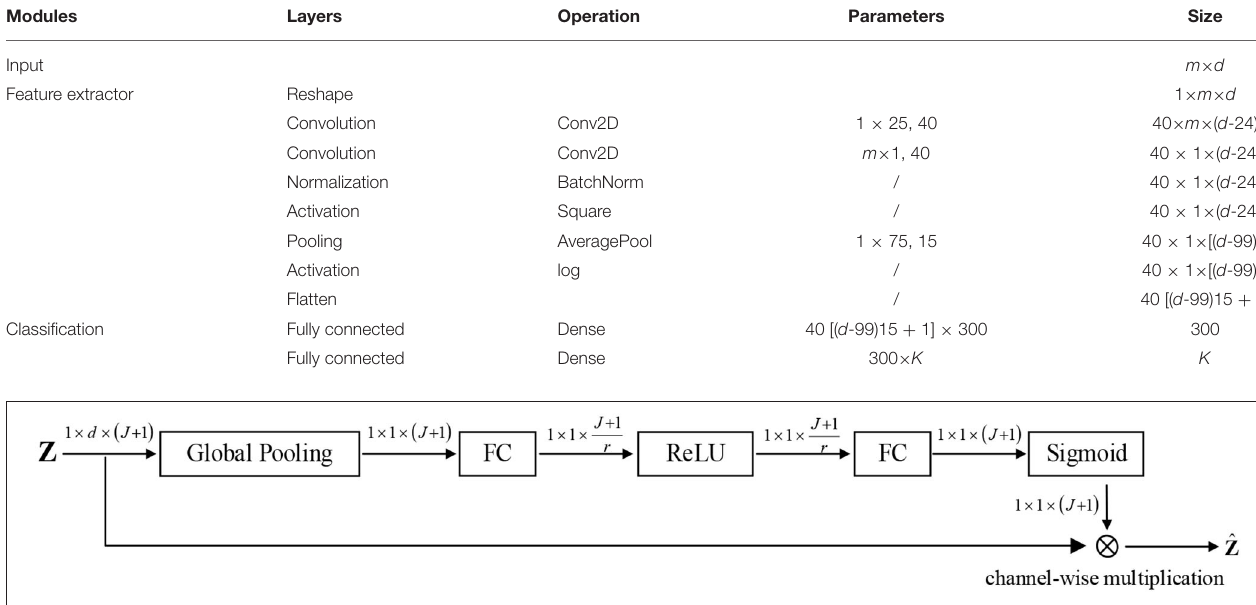
FIGURE 3 | Schema of the region-attention network.